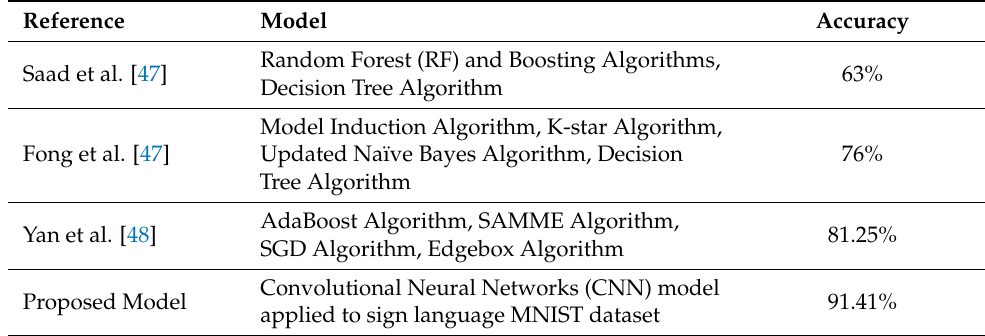
Table 2. Comparison between proposed and state-of-the-art